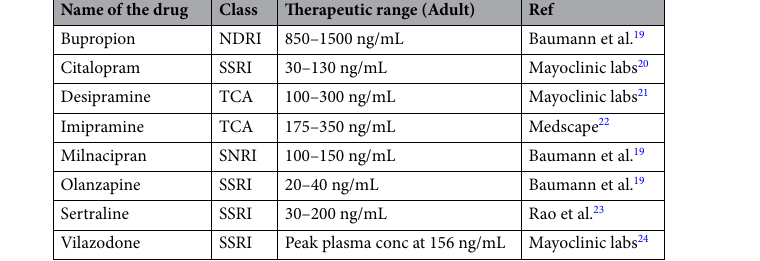
Table 2. Therapeutic ranges for the antidepressants